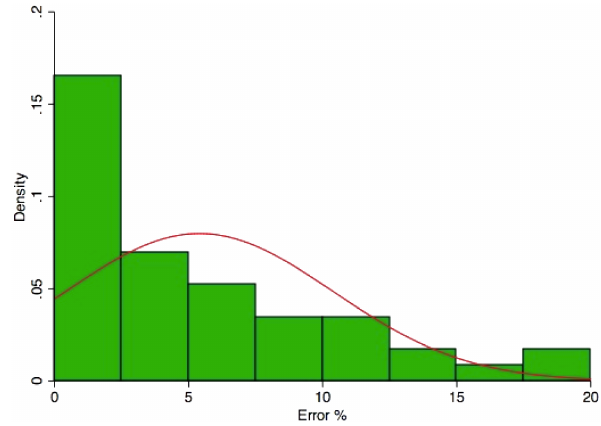
Figure 1. Probability density function of the reported mean abso- lute percentage error in remotely sensed ET estimates. A season or longer period was